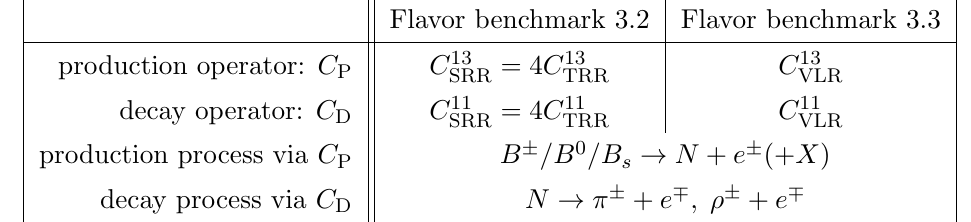
Table 5 . Summary of (cid:13)avor benchmark 3.